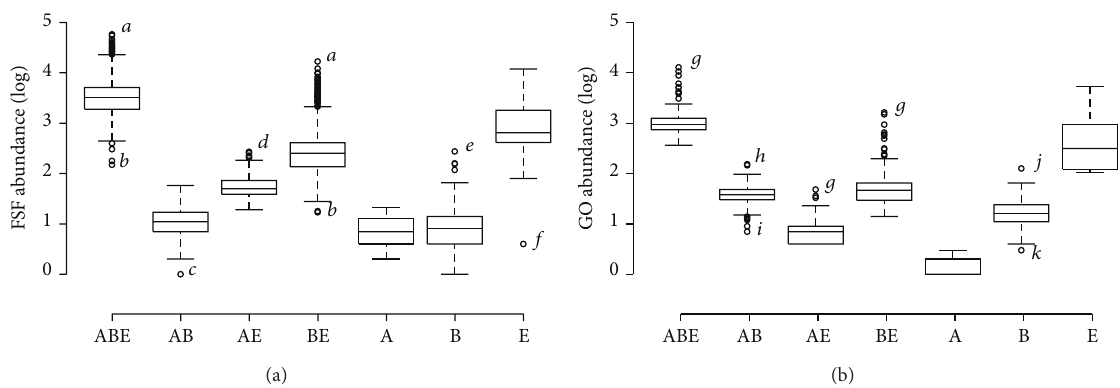
Figure 4: Boxplots comparing the log-transformed abundance values of structural (a) and functional (b) traits in the proteomes and functionomes of the seven Venn taxonomic groups. Italicized characters identify outliers with maximum and minimum abundance of traits in eachgroup: a,Takifugurubripes;b,Cand. HodgkiniacicadicolaDsem; c,MycoplasmagenitaliumG37;d,Zeamays;e,Mycobacteriummarinum; f, Guillardia theta; g, Homo sapiens; h, Rhodospirillum rubrum; i, Desulfurococcus kamchatkensis; j, Ralstonia eutropha; k, Thermosipho